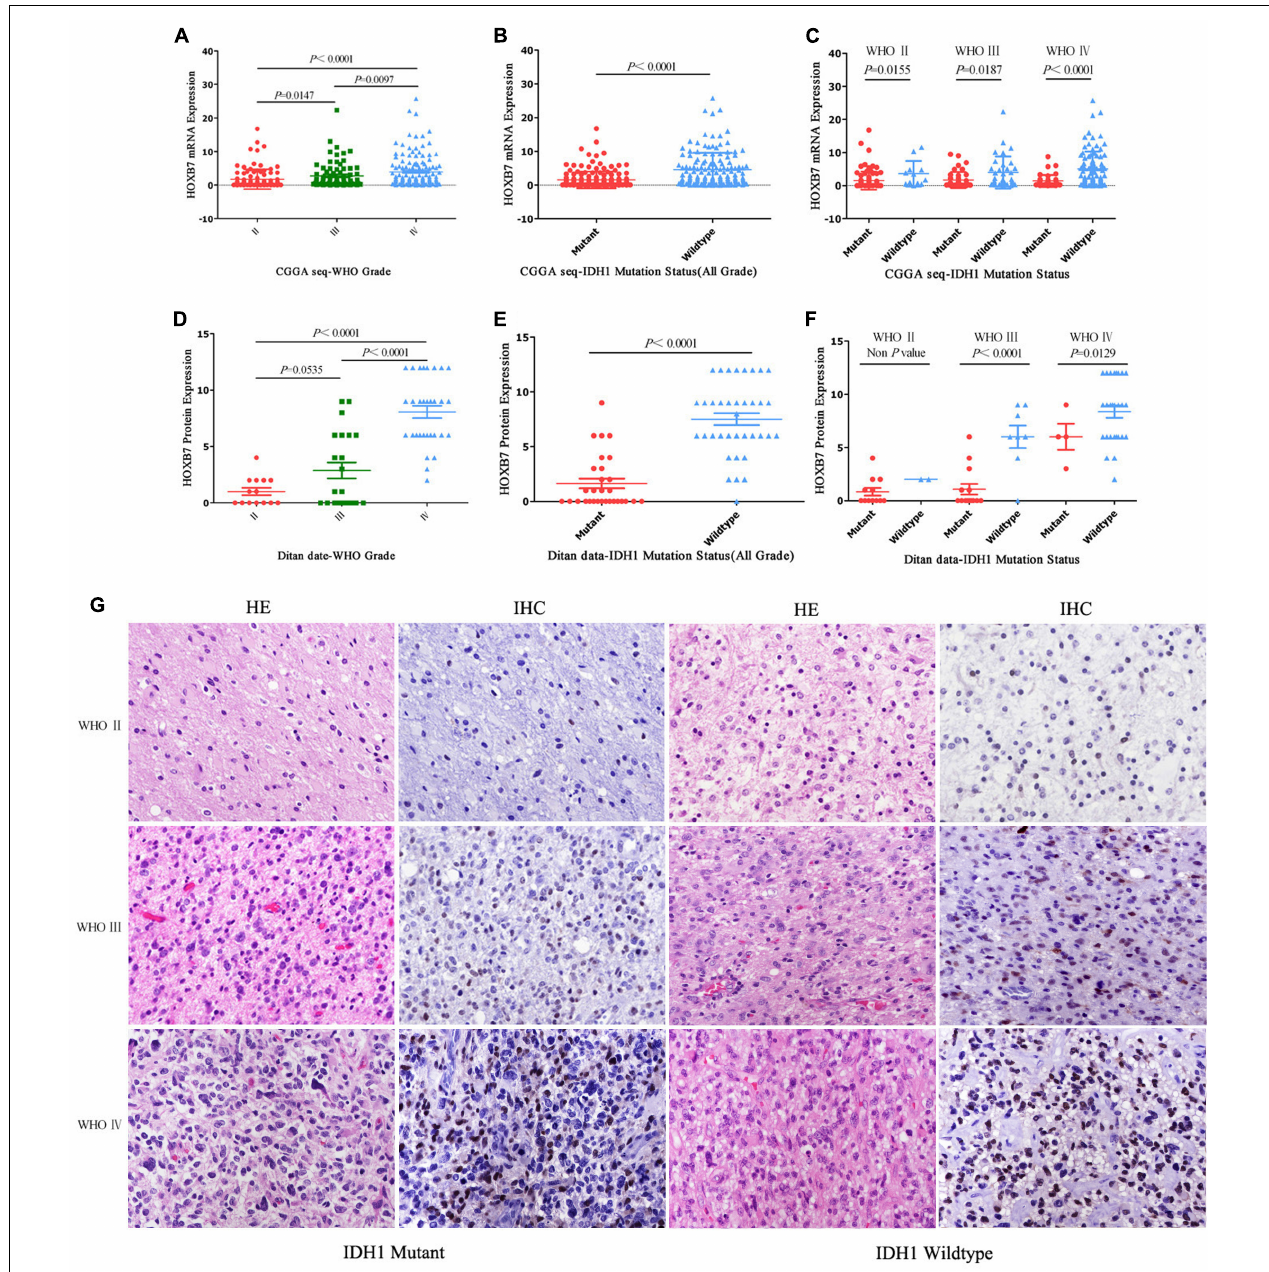
FIGURE 2 | Homeobox B7 (HOXB7) expression pattern in CGGA RNA-seq cohort and Ditan Hospital cohort. HOXB7 is enriched in high-grade gliomas in CGGA RNA-seq database (A) and Ditan Hospital database (D) . HOXB7 is enriched in IDH1-wildtype gliomas in CGGA RNA-seq database (B,C) and Ditan Hospital database (E,F) . Immunohistochemical staining of HOXB7 protein expression in different WHO grade gliomas [ (G) , HE, EnVision, serial sections, Original magnification × 400]. HOXB7 protein is located in the nucleus of tumor cells. With the increase of WHO grade, the number of positive tumor cells increased as well as the enhanced intensity of positive signal. In the same WHO grade glioma, the HOXB7 protein was expressed more highly in IDH1 wild type than that in IDH1 mutant type. The semi-quantitative scoring (expression intensity × expression area) of each specimen are as follows. WHO II and IDH1 Mutant: (1 × 1 = 1), WHO II and IDH1 Wild: (2 × 1 = 2), WHO III and IDH1 Mutant: (2 × 2 = 4), WHO III and IDH1 Wild: (2 × 3 = 6), WHO IV and IDH1 Mutant: (3 × 2 = 6), WHO IV and IDH1 Wild: (3 × 3 = 9).